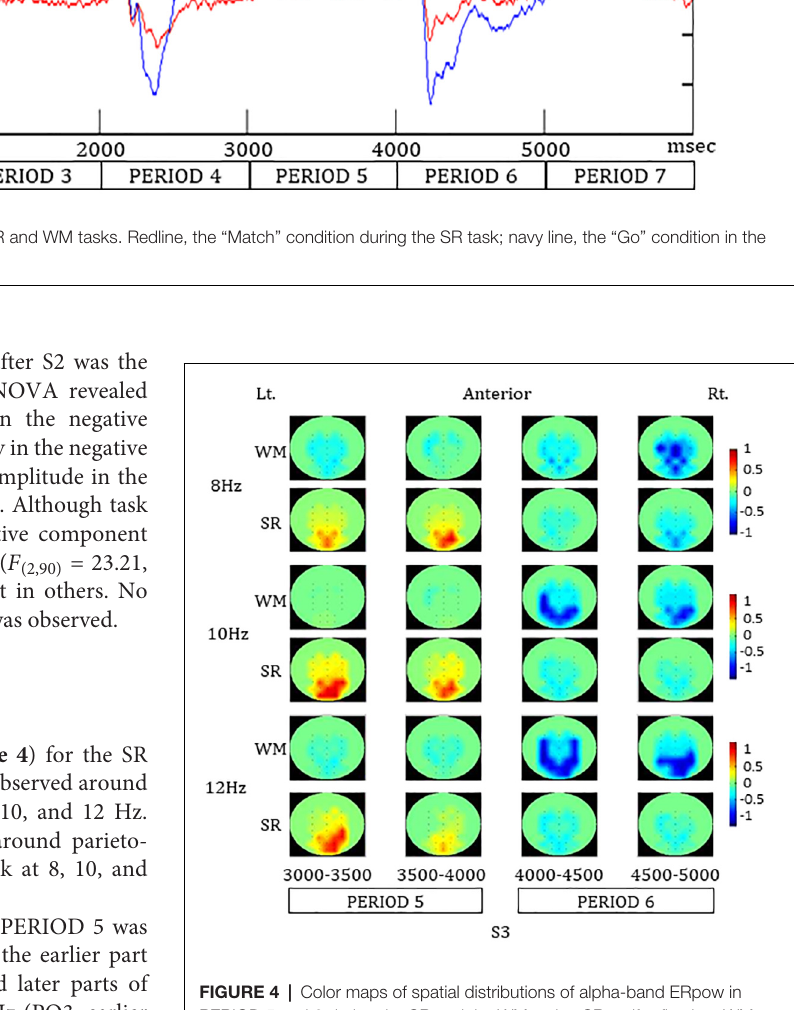
FIGURE 4 | Color maps of spatial distributions of alpha-band ERpow in PERIOD 5 and 6 during the SR and the WM tasks. SR, self-reflection; WM, working